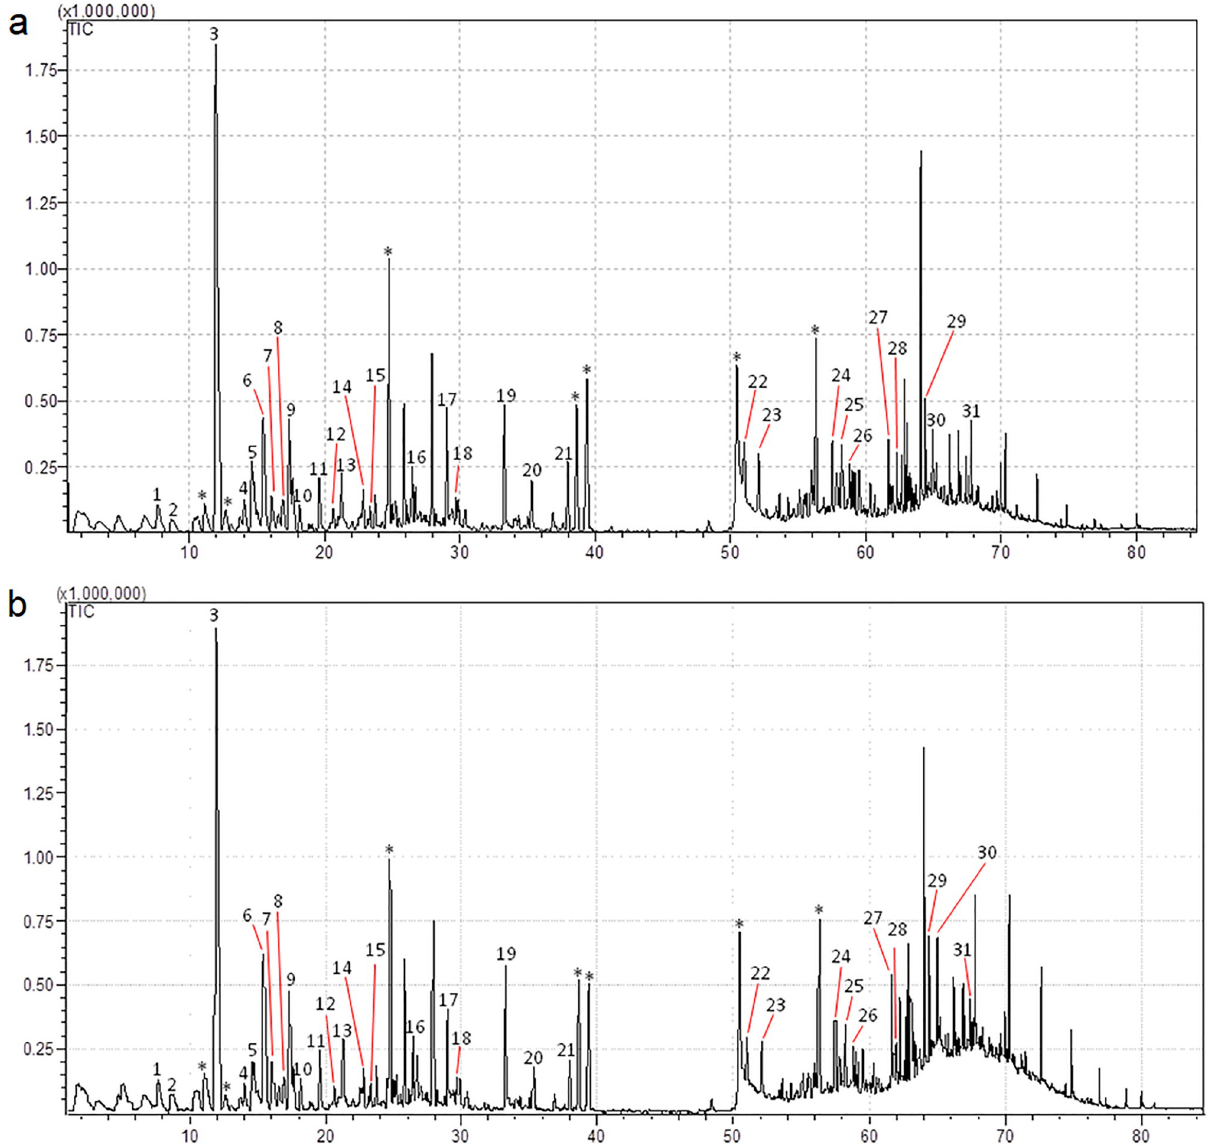
Fig 5. Chromatogram of volatile compounds profiles obtained from analysis of fur samples from uninfected (a) and infected (b) mice. The identified volatile compounds are numbered, and � indicates external contaminants.